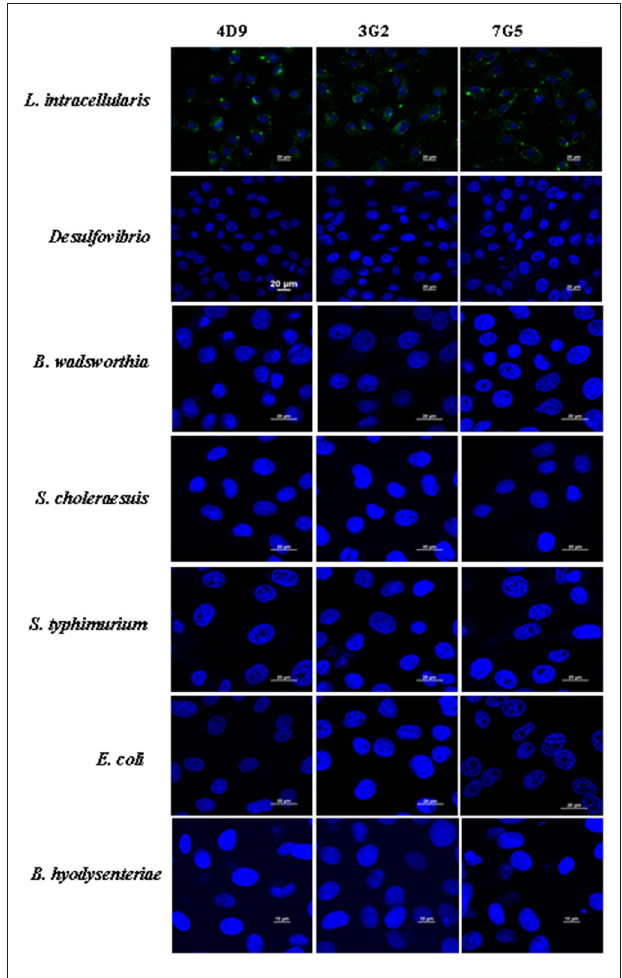
FIGURE 5 | Immunofluorescence results using 4D9 MAb, 3G2 MAb, and 7G5 MAb to evaluate the cross-reactivity with Desulfovibrio , B. wadsworthia , S. choleraesuis , S. typhimurium, E. coli , and B. hyodysenteriae after incubated with IEC-18 cells for